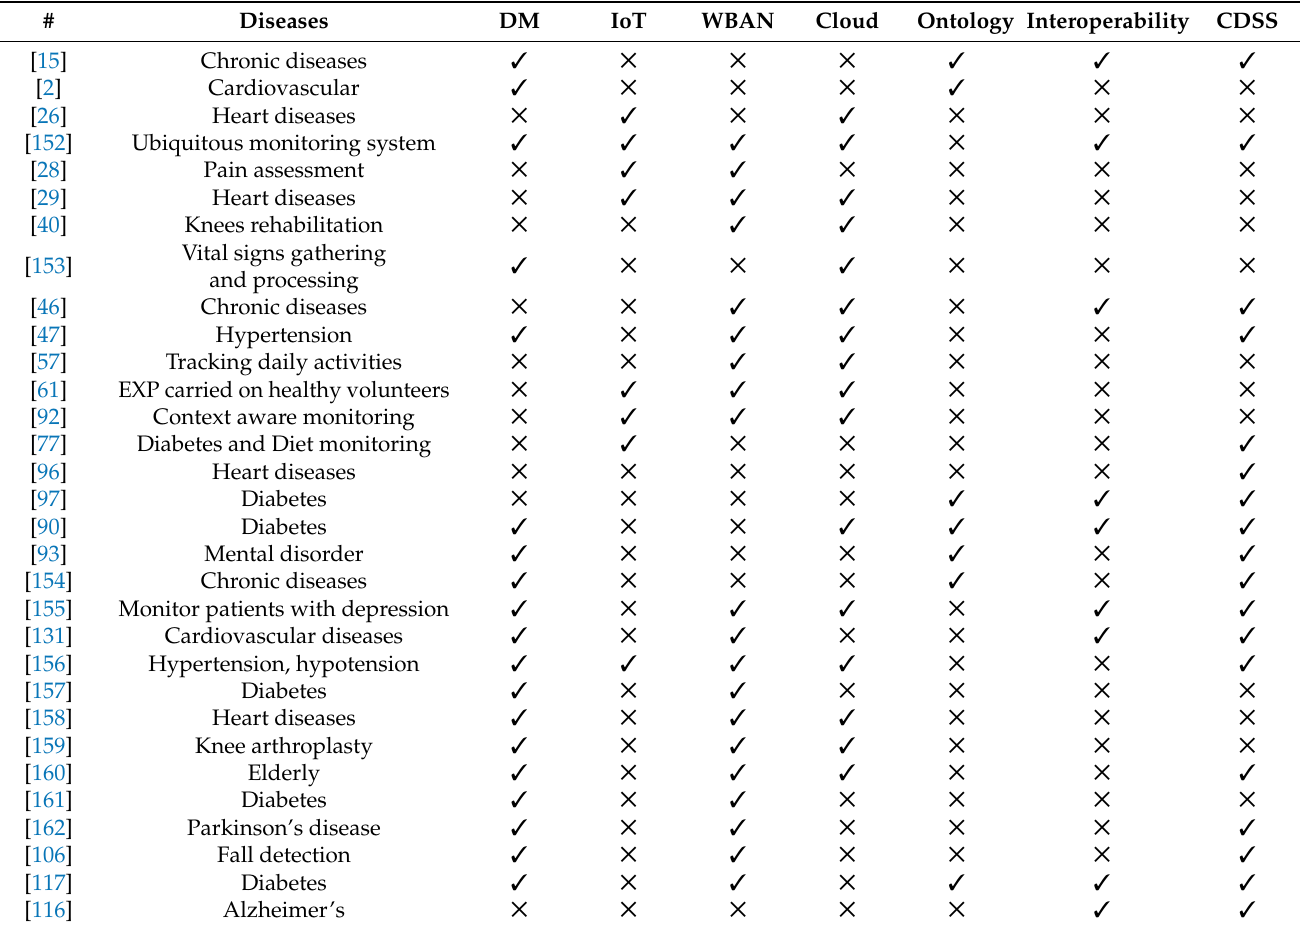
Table 7. Comparison between RPM